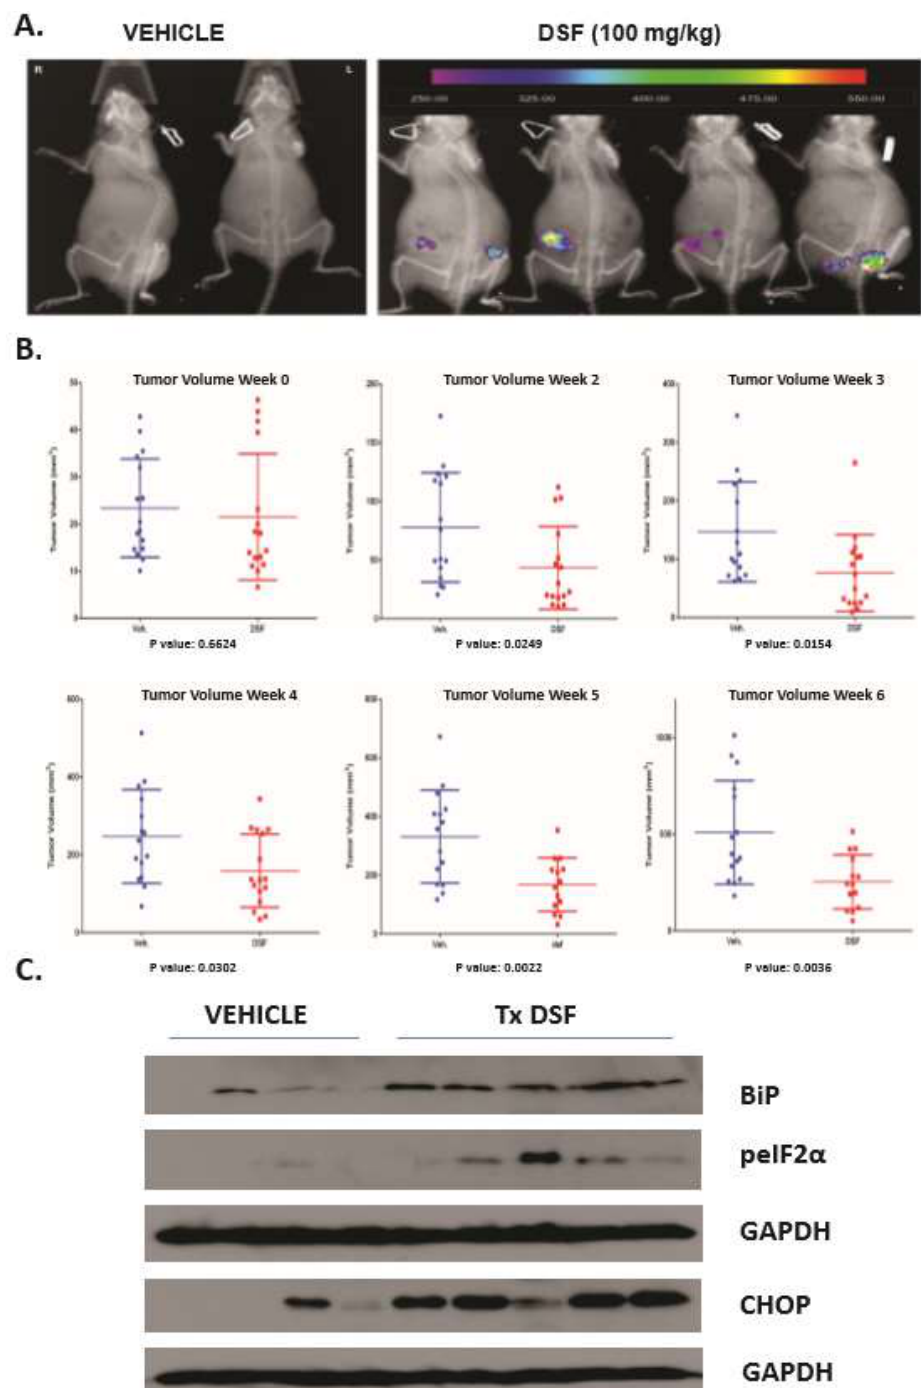
Figure 5. DSF activates UPR in OSCC xenografts and reduces tumor burden. ( A ), Bioluminescent imaging (BLI) to appreciate CHOP-luciferase activity in mice bearing 3–5 mM tumors. ( B ), Volumetric (caliper) evaluation of tumors in 8 mice bearing bilateral xenografts and treated either with almond oil carrier or compounding pharmacy prepared DSF over 6 weeks. ( C ), Immunoblot analysis of UPR markers in whole tumor lysates prepared from xenografts 8 h after final dose of DSF or vehicle, blots were stripped and re-probed for monoclonal antibodies against human GAPDH.